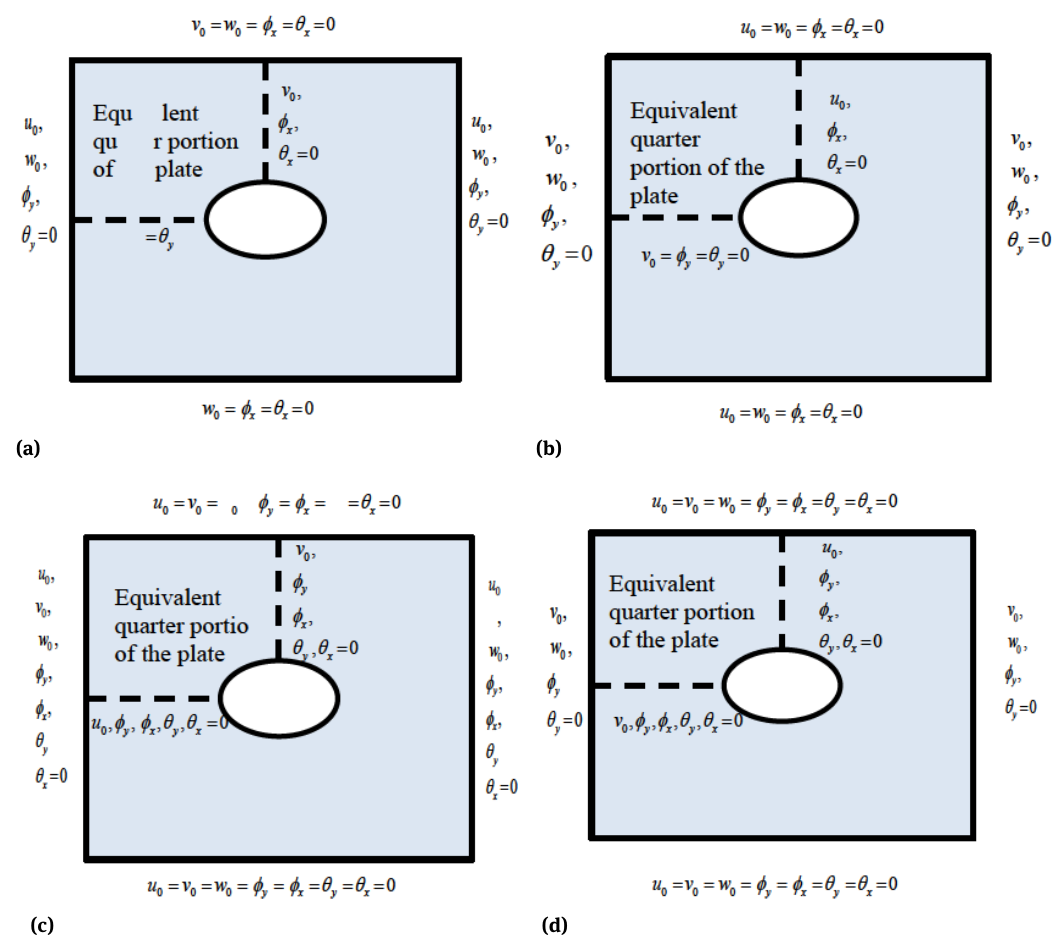
Figure 2: Boundary condition of full plate with hole and equivalent quarter portion of the plate (a) SSSS1; (b) SSSS2; (c) CCCC; (d) CSCS